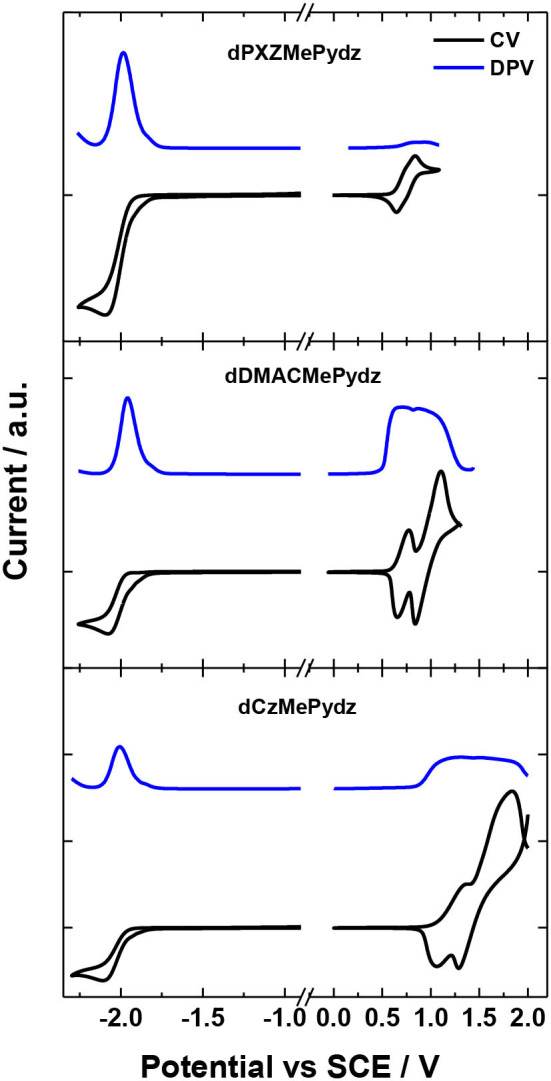
CV and DPV curves of dPXZMePydz, dDMACMePydz, and dCzMePydz. Oxidation measured in DCM and reduction in DMF (scan rate: 0.03 V/s).